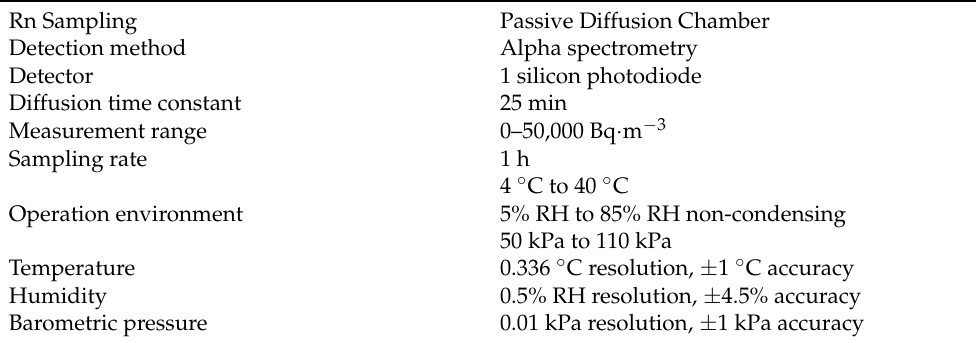
Table 1. Technical specifications of the AirThings Corentium Plus Rn Monitor probes, model QRI, used in the different phases of monitoring the indoor Rn concentration.